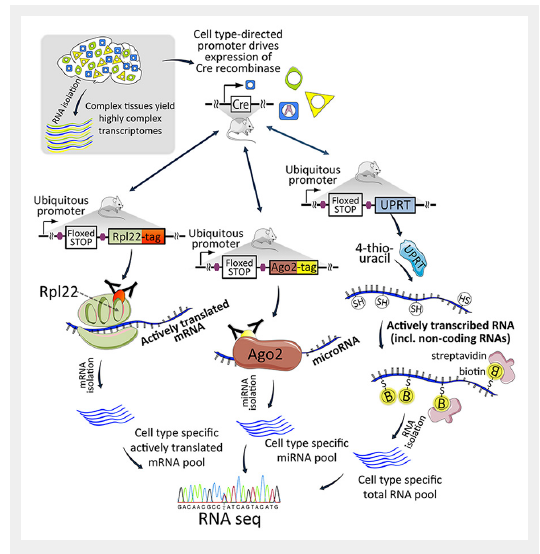
Transgenic techniques for cell type-specific RNA capture. A mouse expressing Cre recombinase is bred with a mouse encoding transgenes for RNA capture components. Each transgene is activated by Cre to drive cell type-specificity. The Rpl22 (ribosomal protein L22) protein captures ribosomes and ribosome-bound mRNAs during translation (the Ribotag method). The Ago2 protein captures the RISC complex and associated miRNAs. The UPRT enzyme converts 4-thiouracil into a nucleotide that is incorporated into newly transcribed RNA. Ago2 = Argonaute2; miRNA = microRNA; RISC = RNA-induced silencing complex; UPRT = uracil phosphoribosyltransferase